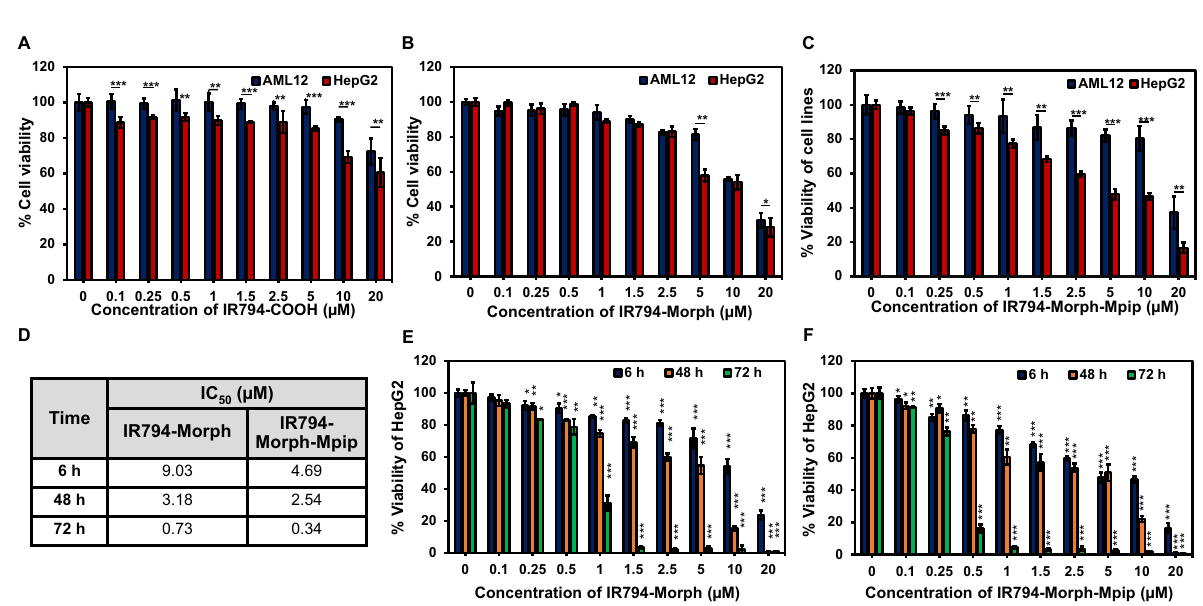
Figure 4. Relative viabilities of AML12 cells (blue bars) and HepG2 cells (red bars) after exposure to IR794- COOH ( A ), IR794-Morph ( B ) and IR794-Morph-Mpip ( C ) at various concentrations (0 ‒ 20 μM) for 6 h. ( D ) IC 50 values of IR794-Morph and IR794-Morph-Mpip treated with HepG2 for 6, 48 and 72 h. Relative viabilities of HepG2 cells treated with IR794-Morph ( E ) and IR794-Morph-Mpip ( F ) for 6 h (blue bars), 48 h (orange bars) and 72 h (green bars). Statistical analysis is based on Paired Student’s T-test analysis (*P < 0.05, **P < 0.01, ***P < 0.001) where ( A – C ) is the comparison between AML-2 and HepG2 at the same concentration; ( E , F ) is the comparison between the treatment and the